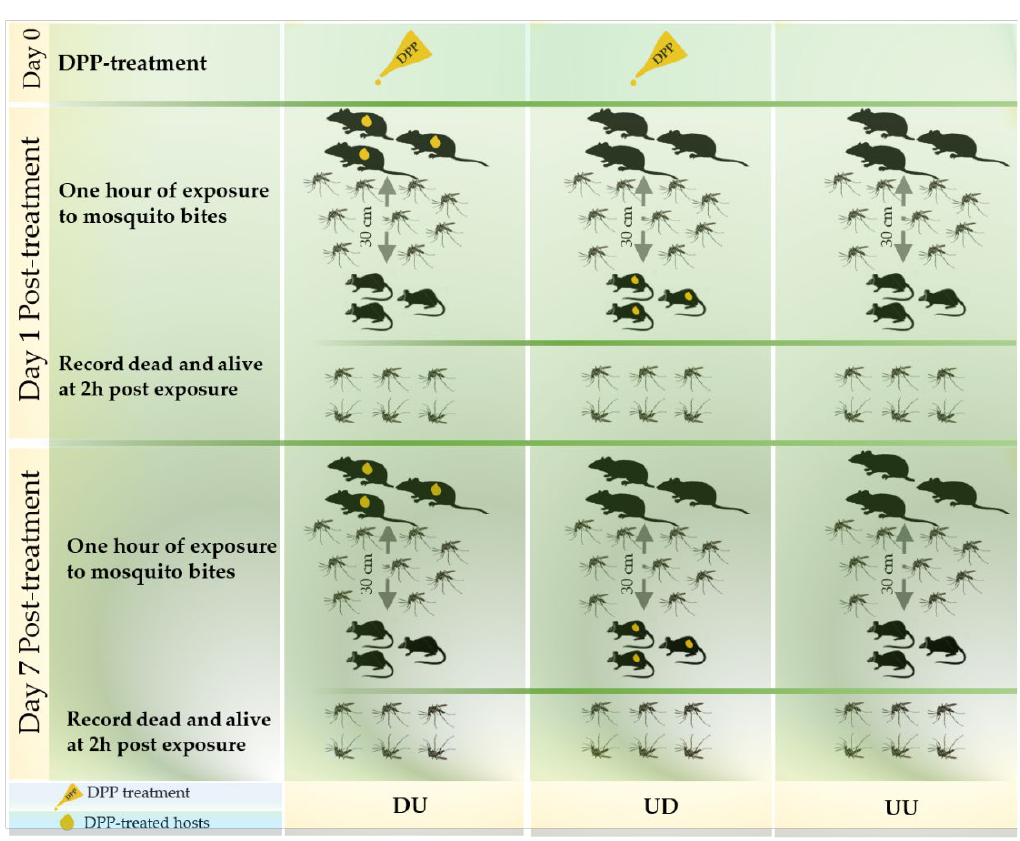
Figure 1. Overview of the study designs of the rat–mouse model.